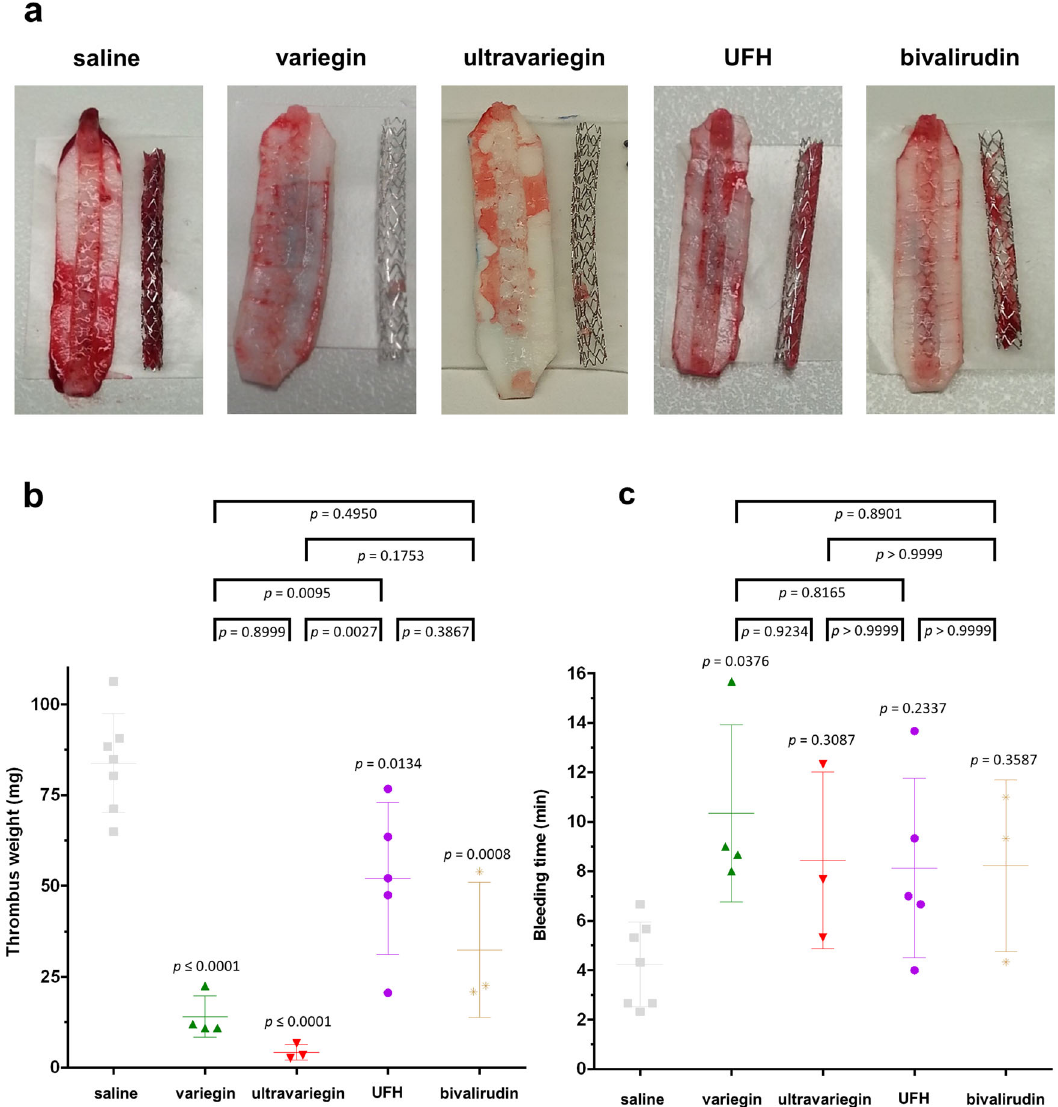
Fig. 5 Ef fi cacy-safety pro fi les of anticoagulants (without DAPT) in porcine models. Ef fi cacy and safety were determined using ex vivo stent thrombosis and super fi cial ear vein bleeding models, respectively. a Representative photographs showing thrombi formed on coronary stents and endothelium- denuded pig aorta strips in pigs administered with saline (i.v. bolus, n = 7), 1 mg/kg variegin (i.v. bolus, n = 4), 0.25 mg/kg ultravariegin (i.v. bolus, n = 3), 100 u/kg UFH (i.v. bolus, n = 5) and 0.75 mg/kg (i.v. bolus) plus 1.75 mg/kg/h (i.v. continuous infusion) bivalirudin ( n = 3). Experiments were repeated in the indicated number of animals independently with similar results. b Total weight of thrombi (one-way ANOVA P < 0.0001). c Bleeding time (one-way ANOVA P = 0.0474). Multiplicity-adjusted P values for post hoc Tukey ’ s multiple comparisons between respective anticoagulants with saline were indicated immediately above each treatment. Multiple comparisons among anticoagulants were indicated on top of the plot. Data shown are mean ±